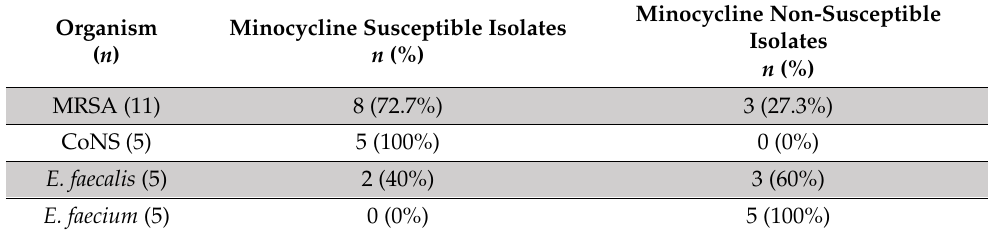
Table 2. Results of minocycline gradient diffusion testing for the PJI clinical isolates that were doxycycline